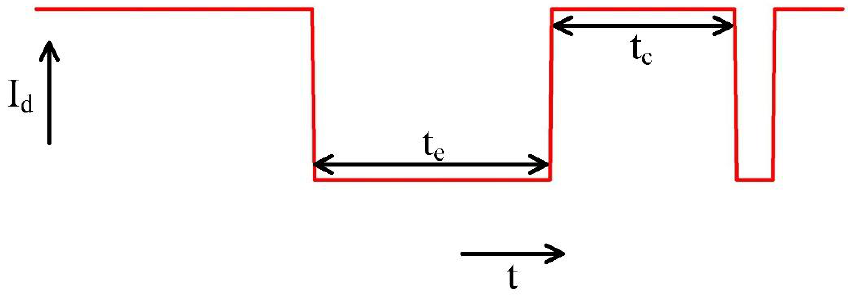
Figure 1. RTN in MOSFET, 𝑡 𝑐 is the capture time and 𝑡 𝑒 is the emission time. The 𝑡 𝑐 and 𝑡 𝑒 appear randomly, obeying the Poisson distribution, and can be de- scribed as [13,14]: